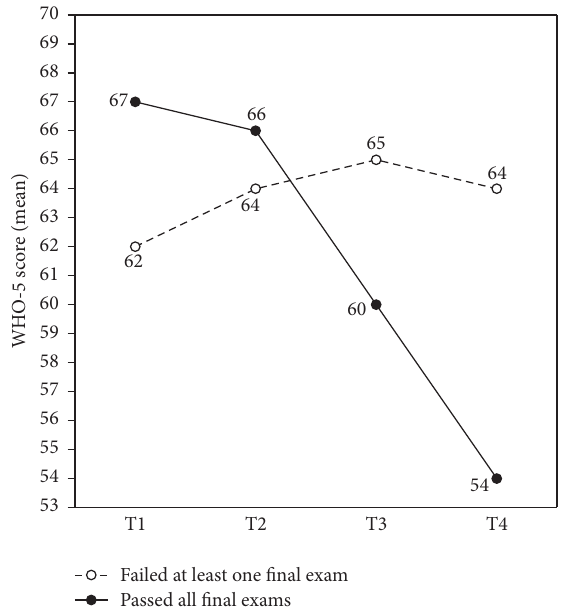
Figure 6: Subgroup analysis of the change of dental students’ positive well-being, according to their ability to pass all final